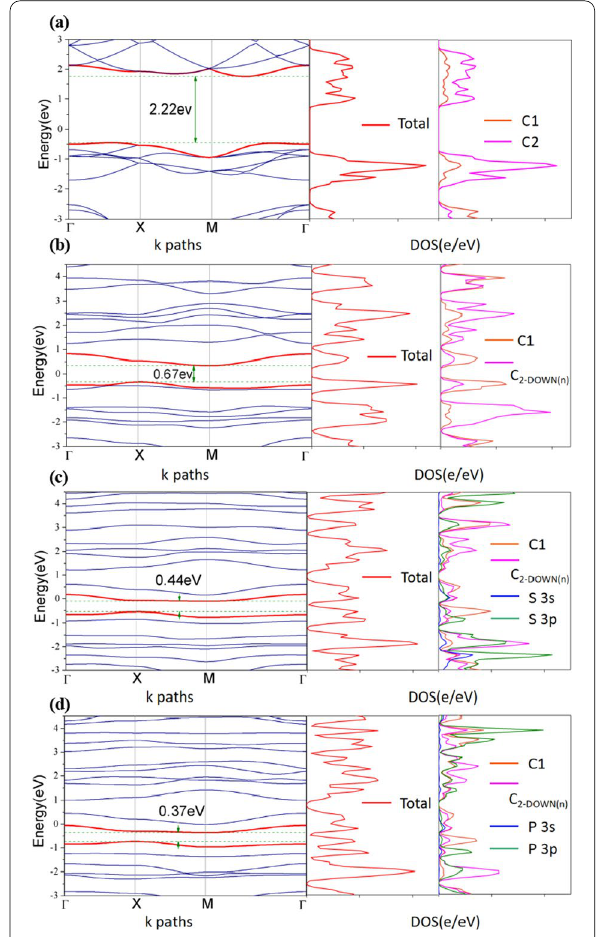
Fig. 5 Electronic band structure, total and projected DOS of the defect and doped PG. a Pristine PG, b V C-UP C2 vacancy site, c V C-UP S-doped and d V C-UP P-doped, respectively. The structures of c and d as shown in Fig. 3. They are calculated by using PBE functional, the Fermi level is shifted to 0.00 eV